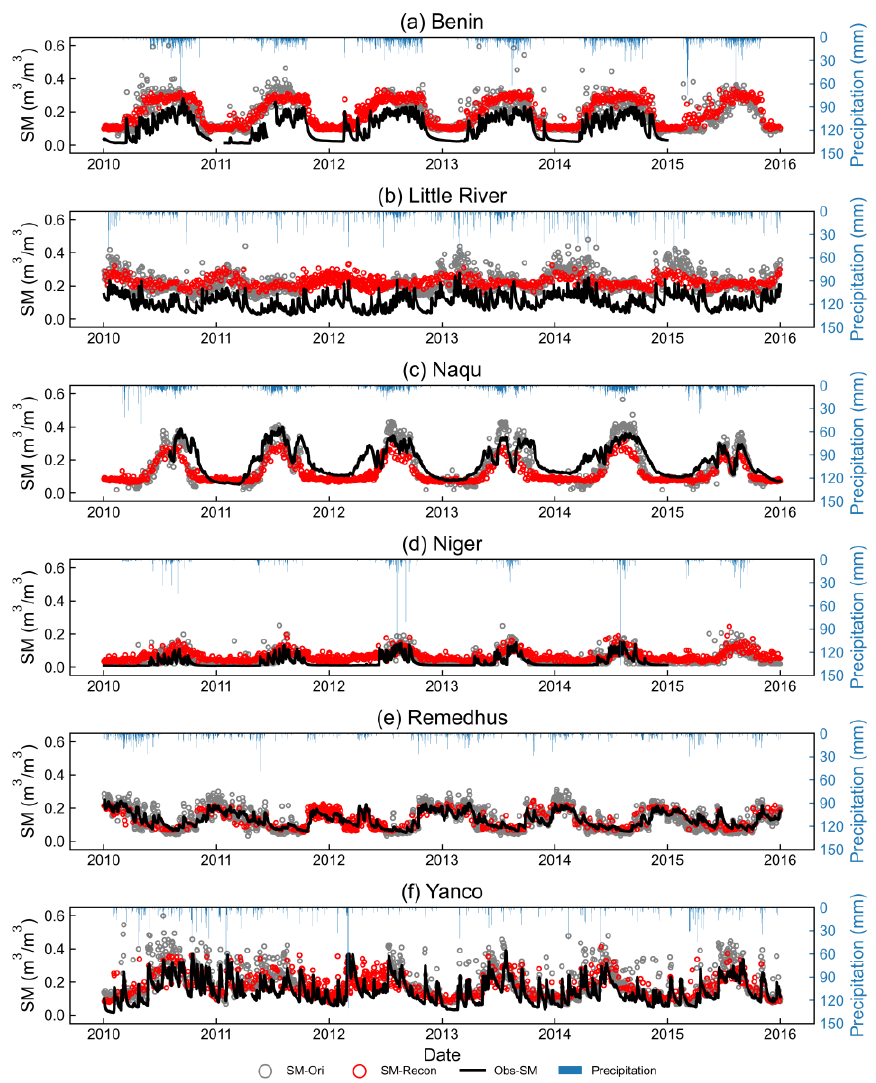
Figure 15. Time series of SM-Ori (grey hollow circles), SM-Recon (red hollow circles), in situ SM (Obs-SM in blackline) and precipitation (blue columnar) in 2010–2016.